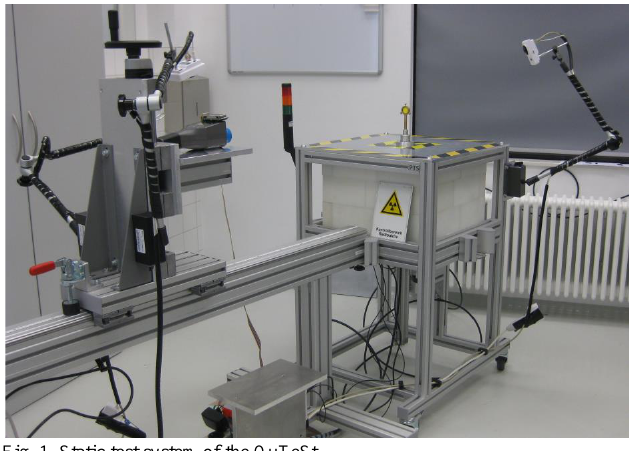
Fig. 1. Static test system of the